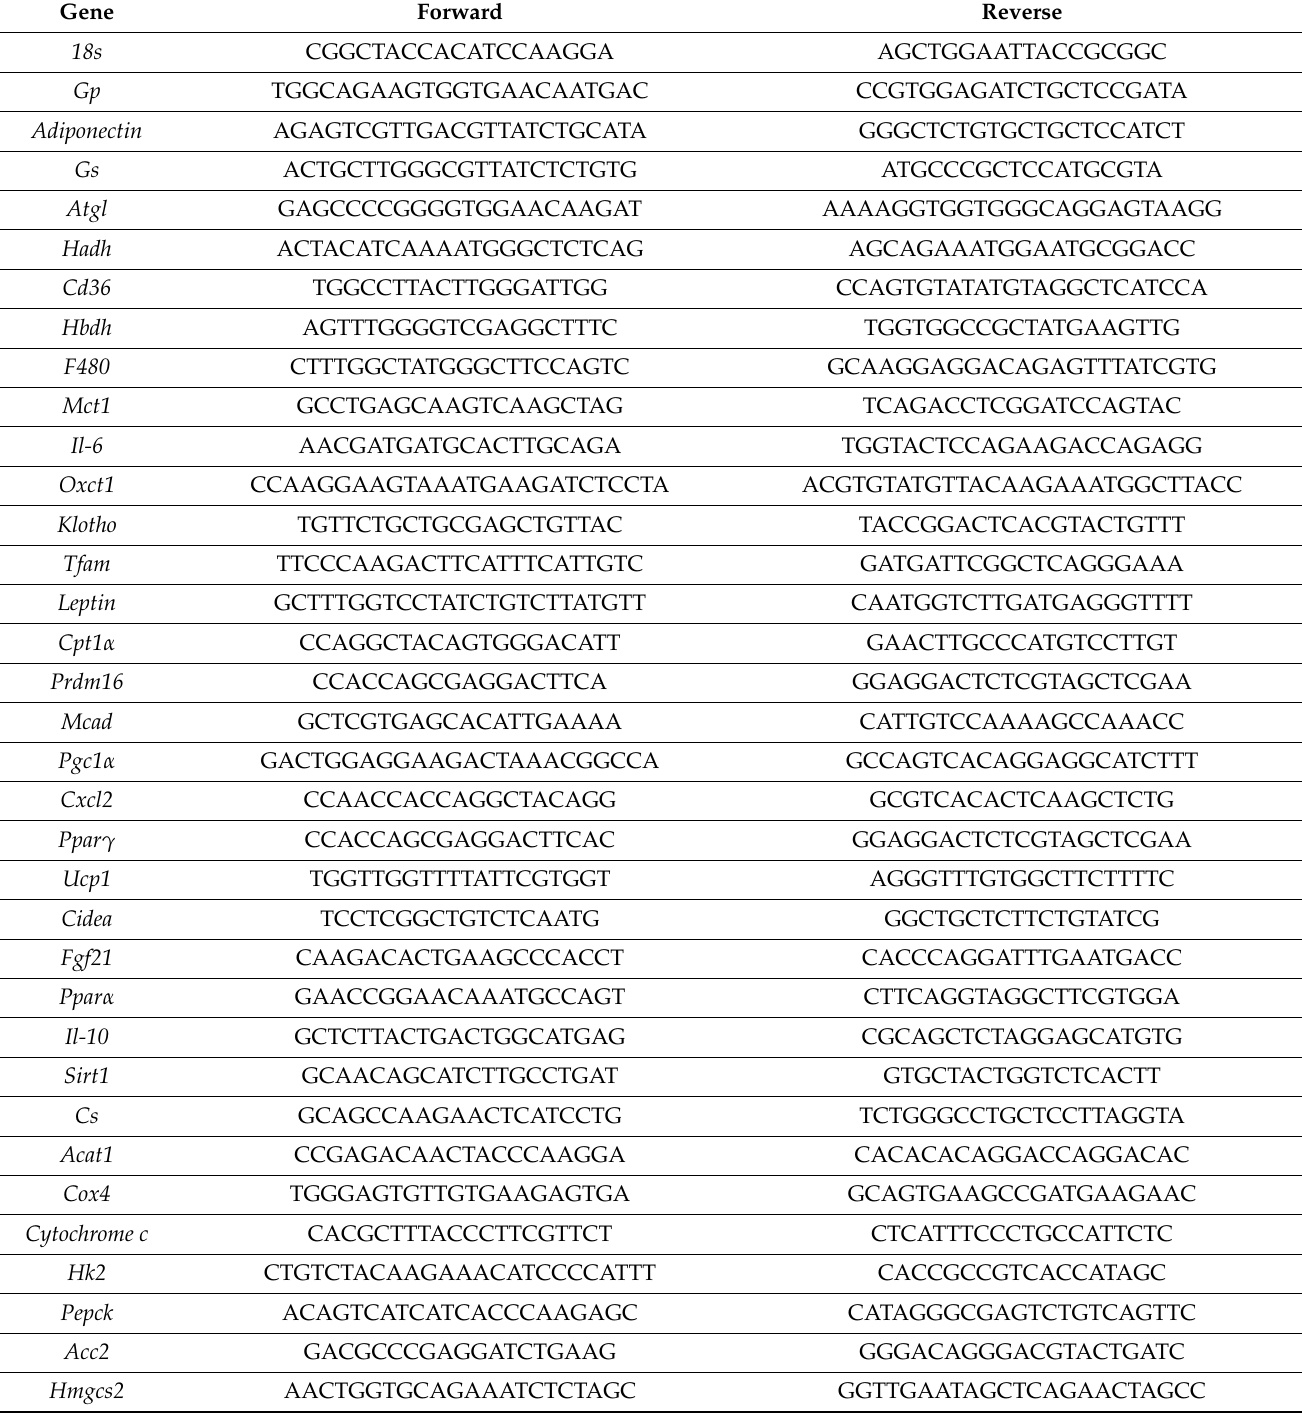
Table 11. List of primers used in real-time